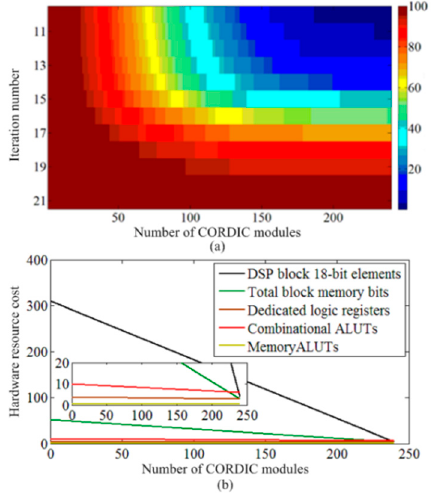
Figure 5. Performance analysis of the proposed CORDIC module. ( a ) The relationship of the computational precision, the iteration number, and the number of the CORDIC modules; ( b ) The relationship between the number of CORDIC modules and the hardware resource cost.